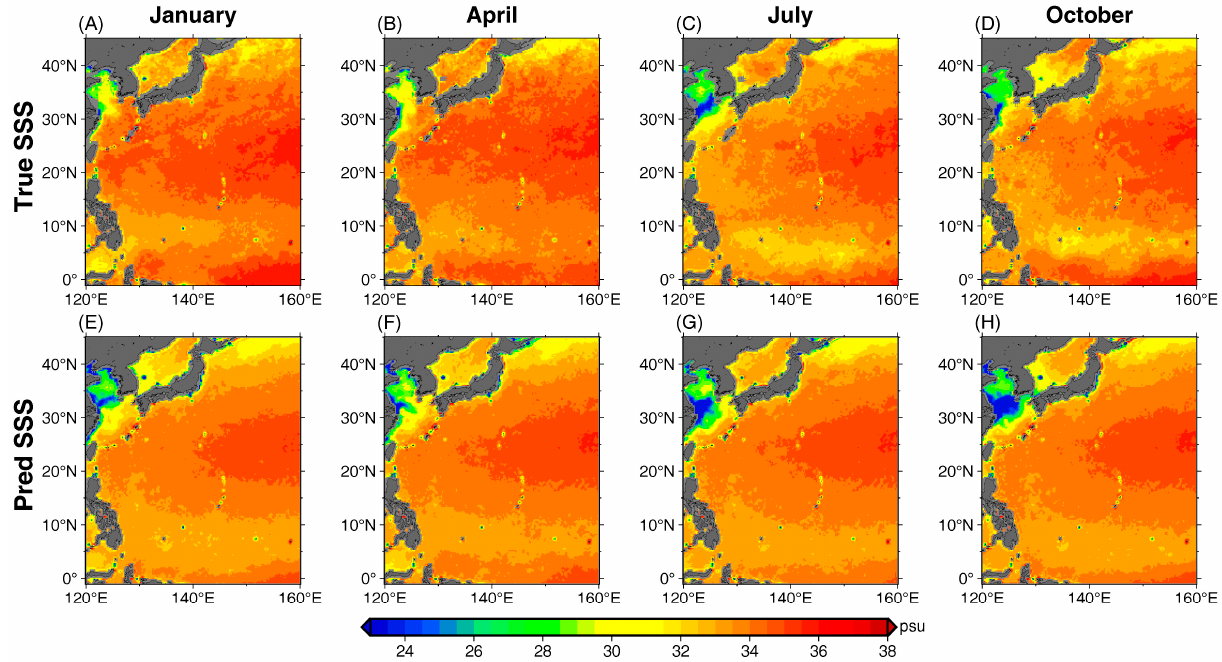
Figure 3. Spatial distributions of true ( A – D ) and predicted SSSs ( E – H ) for 2021 over the western Paci fi c region.